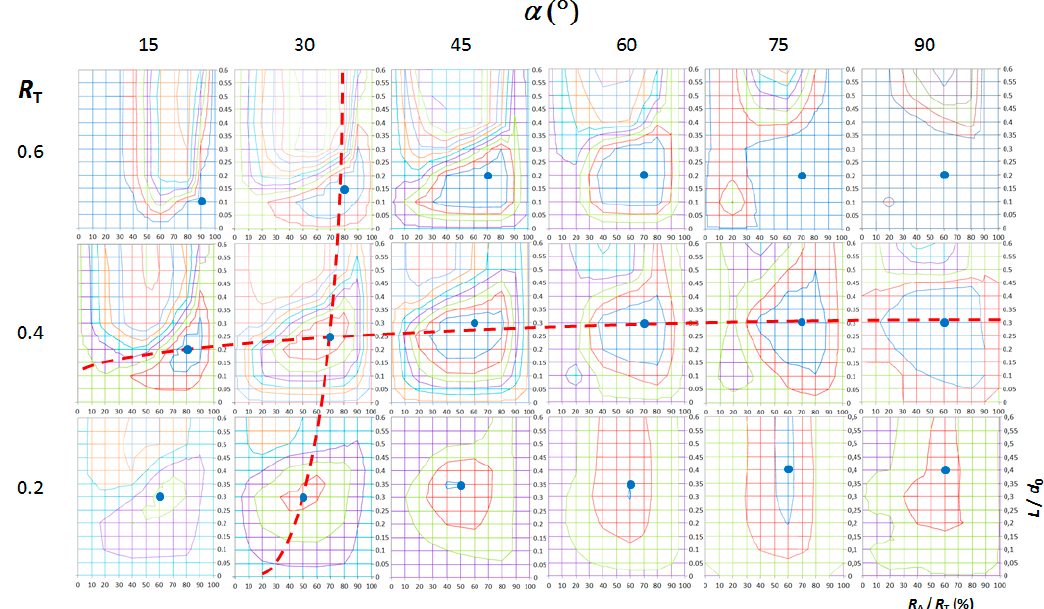
Figure 13. Contours of central damage factors ( C f ) in double-pass extrusions and location of the point of minimum damage.